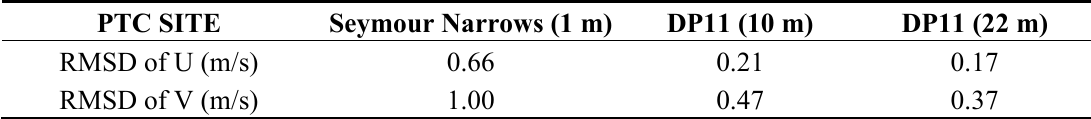
Table 4. Root-mean-square deviation (RMSD) between model derived and the predicted tidal currents